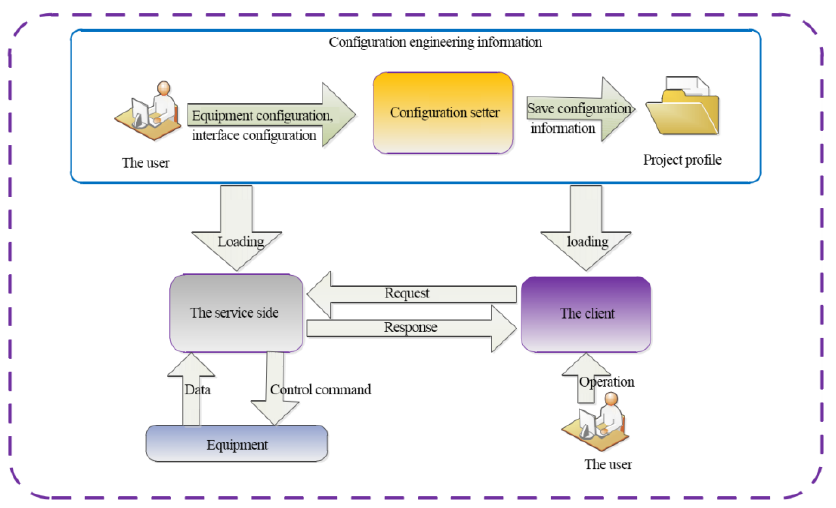
Figure 4. Project creation and loading.